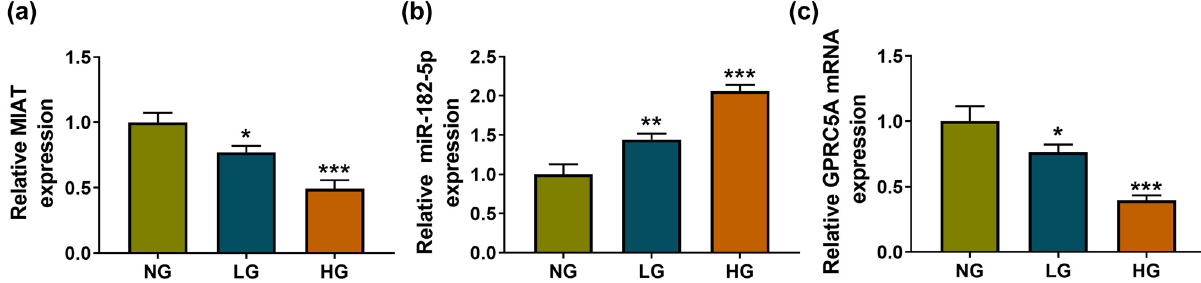
Figure A1: The dysregulation of MIAT, miR - 182 - 5p and GPRC5A after treatment of LG and HG. ( a – c ) RT - qPCR was performed to examine the levels of MIAT ( a ) , miR - 182 - 5p ( b ) and GPRC5A mRNA ( c ) in HK - 2 cells with treatment of NG, LG or HG. * P < 0.05, ** P < 0.01, *** P